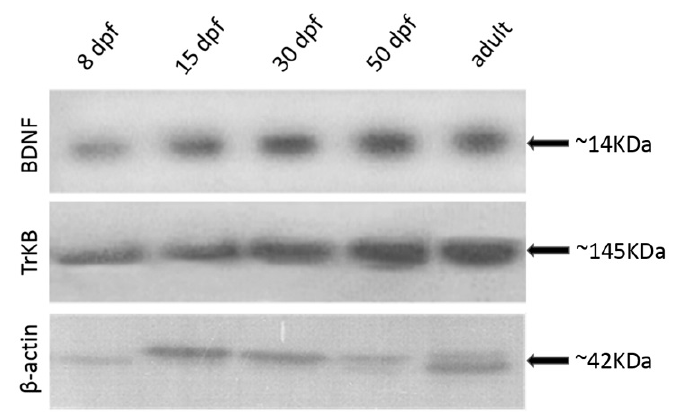
Figure 6. Western blot: detection of BDNF at 8 dpf (line 1), 15 dpf (line 2), 30 dpf (line 3), 50 dpf (line 4), adult stage (line 5). Detection of TrKB at 8 dpf (line 1), 15 dpf (line 2), 30 dpf (line 3), 50 dpf (line 4), adult stage (line 5). β -Actin protein was used as an endogenous control: 8 dpf (line 1), 15 dpf (line 2), 30 dpf (line 3), 50 dpf (line 4), adult stage (line 5).